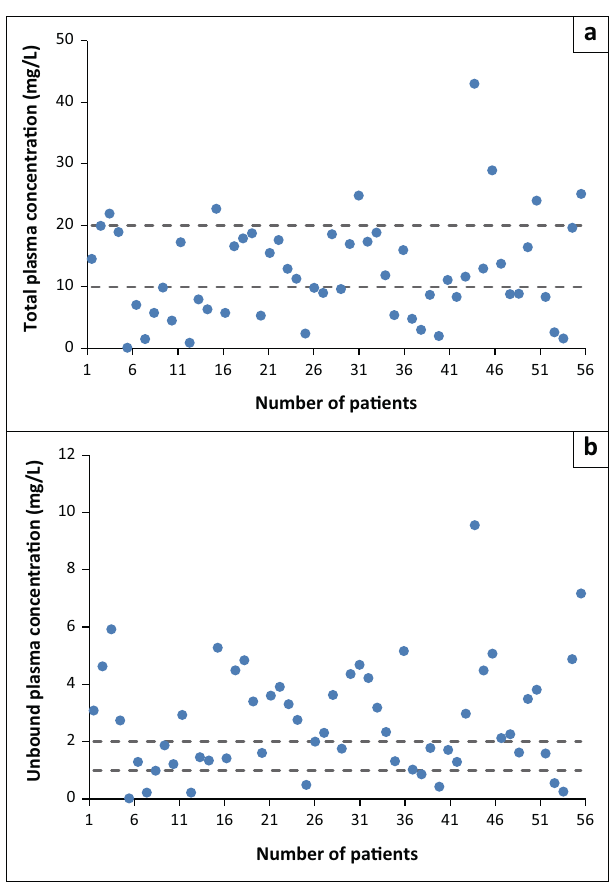
Number of pa(cid:15)ents FIGURE 1: Plasma concentrations of (a) total and (b) unbound phenytoin plasma concentration in 56 critically ill patients in the Intensive Care Unit at Windhoek Central Hospital (Windhoek, Namibia) from January 2013 to July 2019. The therapeutic range is indicated by dashed lines.